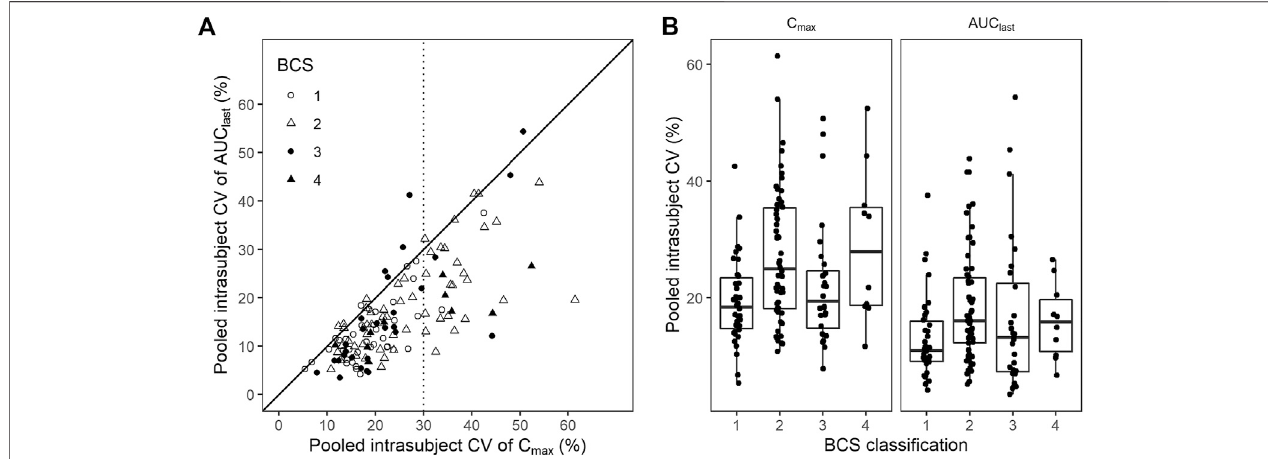
FIGURE4| Coef fi cientofvariation(CV)byBiopharmaceuticsClassi fi cationSystem(BCS)classi fi cation. (A) Scatterplotand (B) boxplotforpooledCVofC max and AUC last by BCS classi fi cation. Black solid line represents line of unity, while dotted line represents CV criterion of the highly variable drugs.